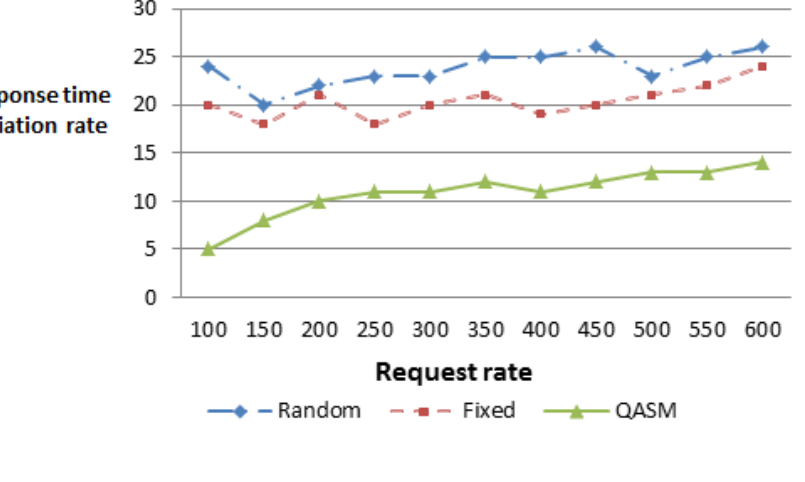
Figure 6. Average response time QoS deviation rate under different system